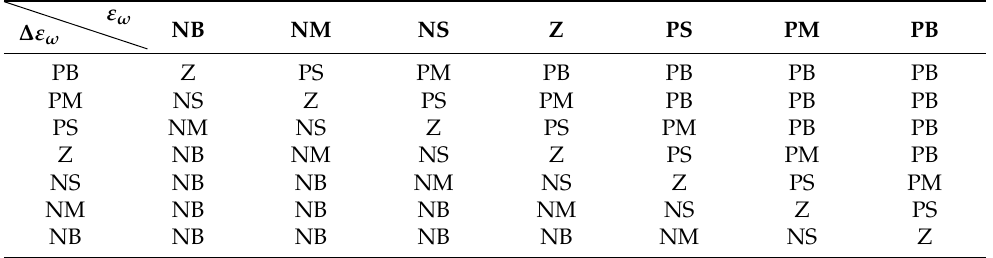
Table 3. Inference matrix of the fuzzy